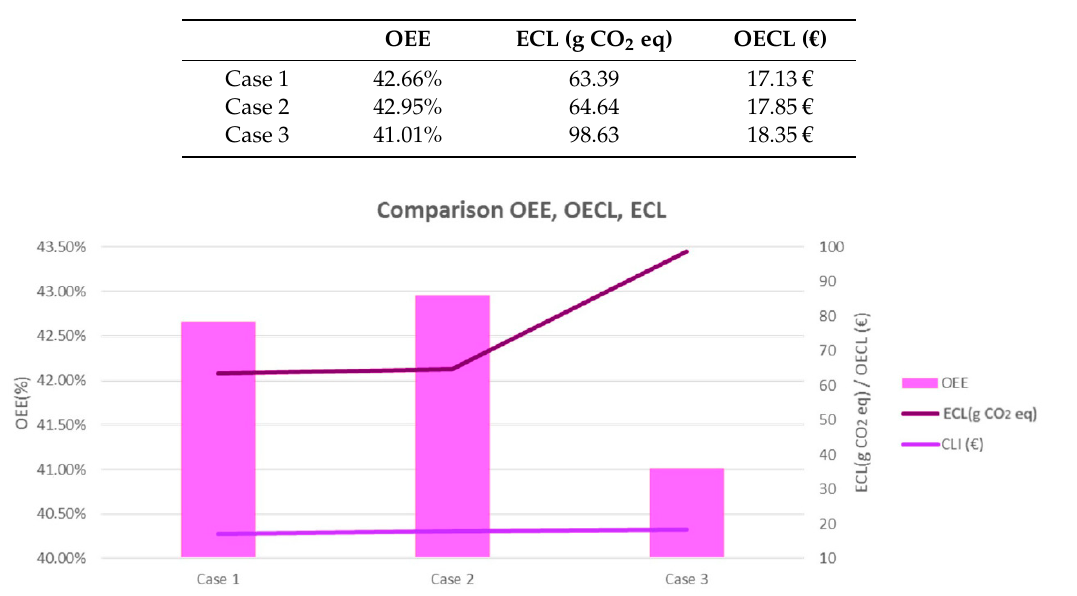
Table 4. OverallEquipmentEffectiveness(OEE),EquipmentCostLoss(ECL),andnewKPIresultssummary.